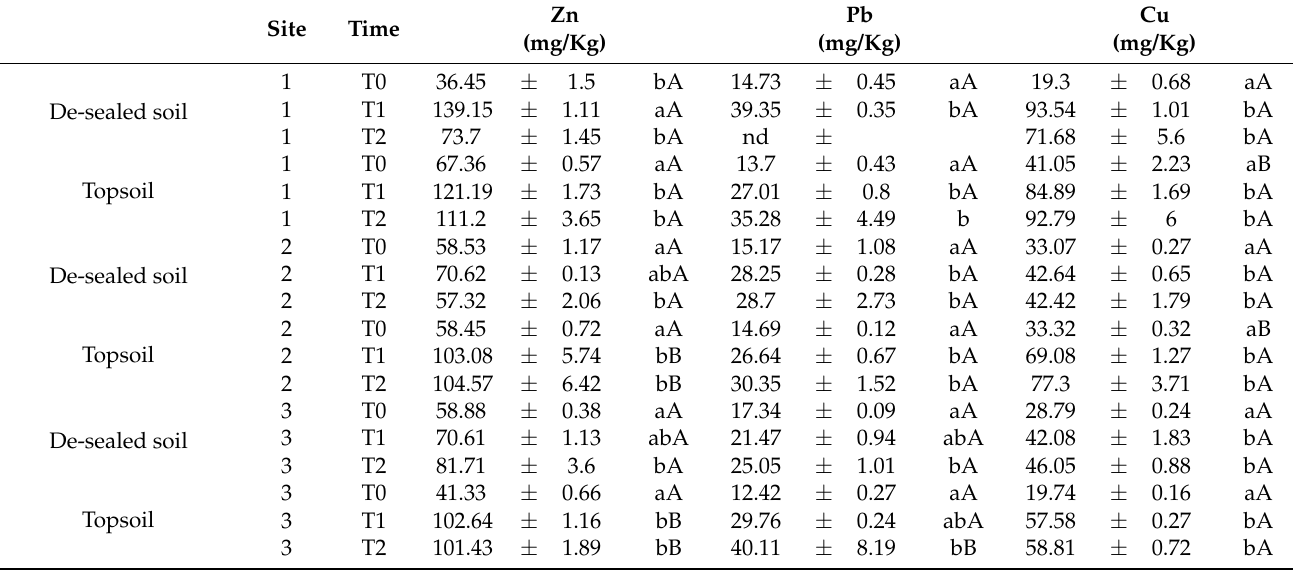
Table 3. Total concentration of carbon Zn, Pb and Cu for Site 1, Site 2 and Site 3 during the three sampling points.